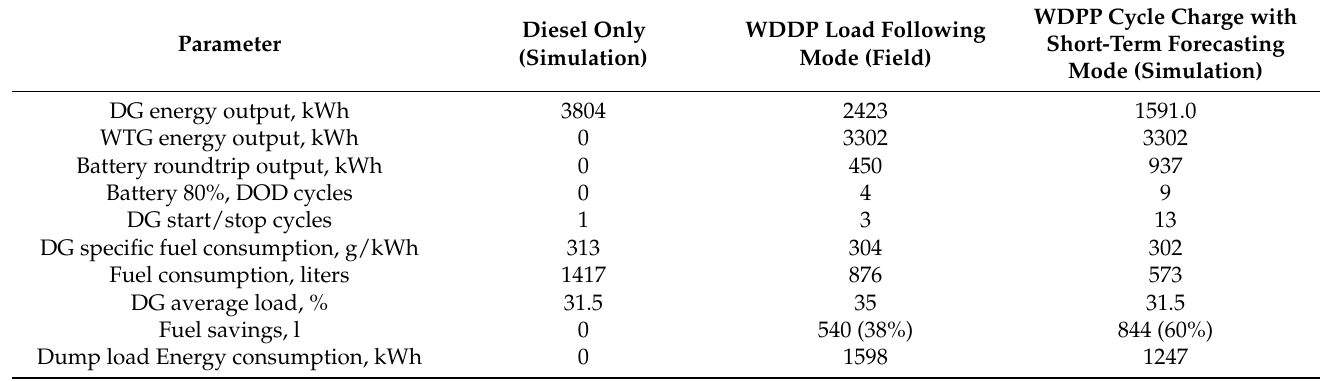
Table 3. Operation statistics over five days.